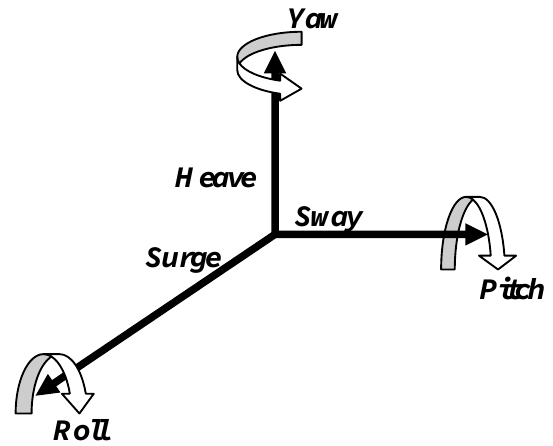
Figure 1. The six independent variables fully describing the motion characteristics of an